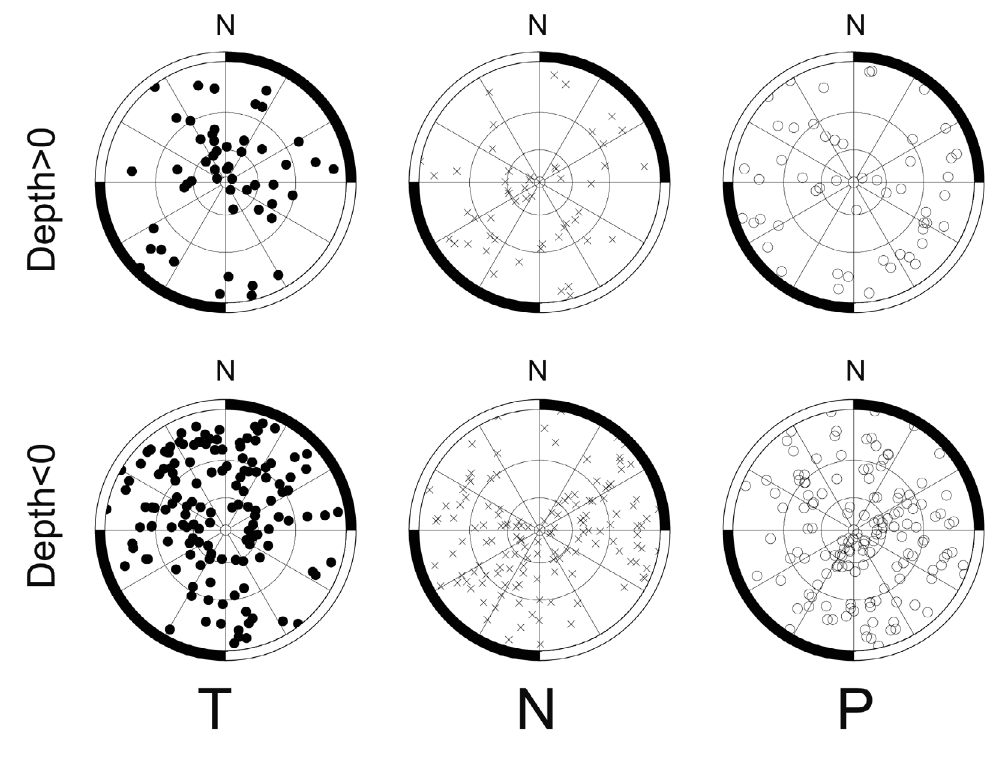
Figure 14. Stereographic plots of tension (T), neutral (N) and pressure (P) axes for the focal mechanisms of Figure 11. The graphics on the top represent data for events located a.s.l. while those on the bottom are for the other